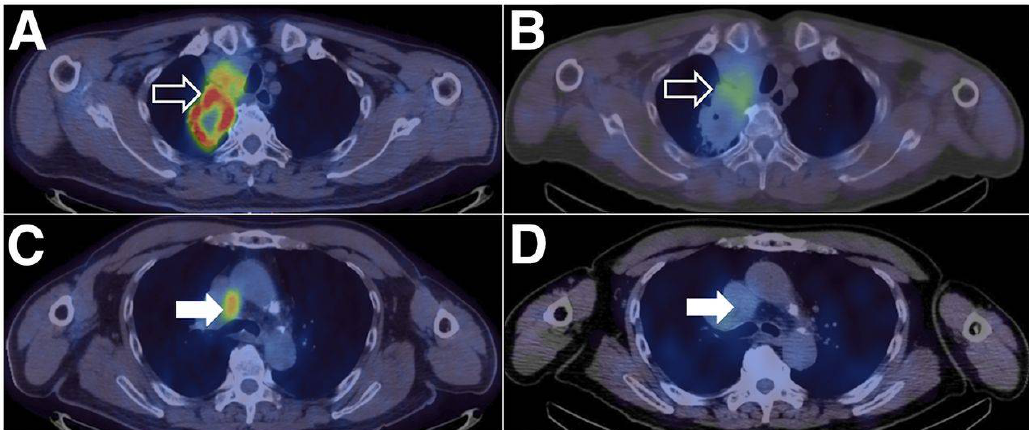
Figure 7. Heterogeneity in PD-L1 expression between primary and nodal sites of disease within the same patient. The right upper lobe tumor (open arrows) shows areas of high [ 18 F]FDG uptake (SUVmax = 16.1) on PET/CT ( A ) and [ 99m Tc]Tc-NM-01 SPECT/CT (T:BP = 3.53) ( B ). The mediastinal lymph nodes (closed arrows) show high [ 18 F]FDG uptake (SUVmax = 6.3) ( C ) but low [ 99m Tc]Tc-NM-01 activity (T:BP = 1.13) ( D ). The figure is reproduced with permission from [54].